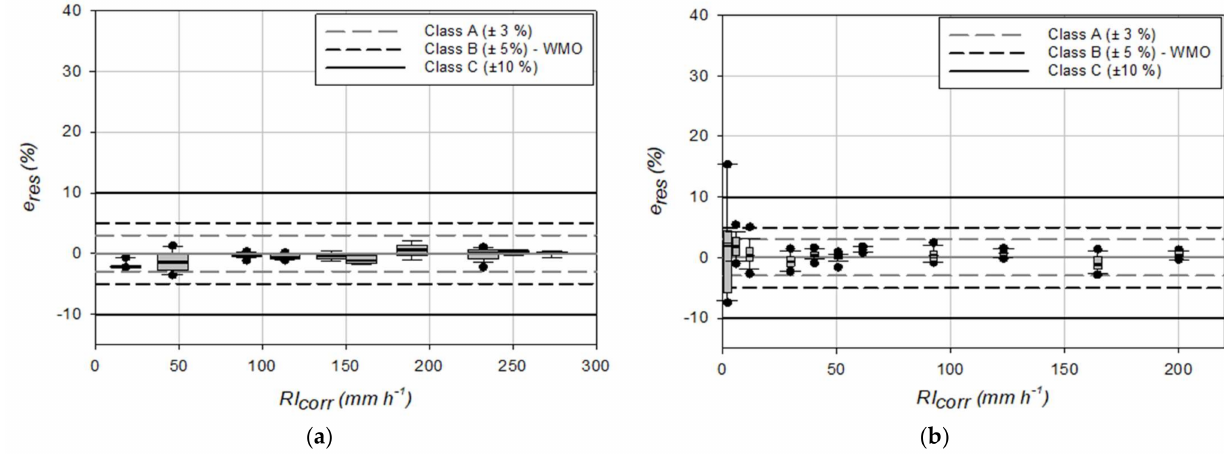
Figure 5. Performance assessment after bias correction according to the calibration curves obtained from dynamic calibration by assuming the actual volume for the generated drops, for ( a ) the OSC gauge and ( b ) the CRAL gauge. Horizontal lines indicate the limit of the European standard classification and the WMO